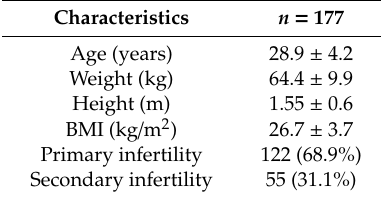
Table 1. Characteristics of Mexican women with Müllerian